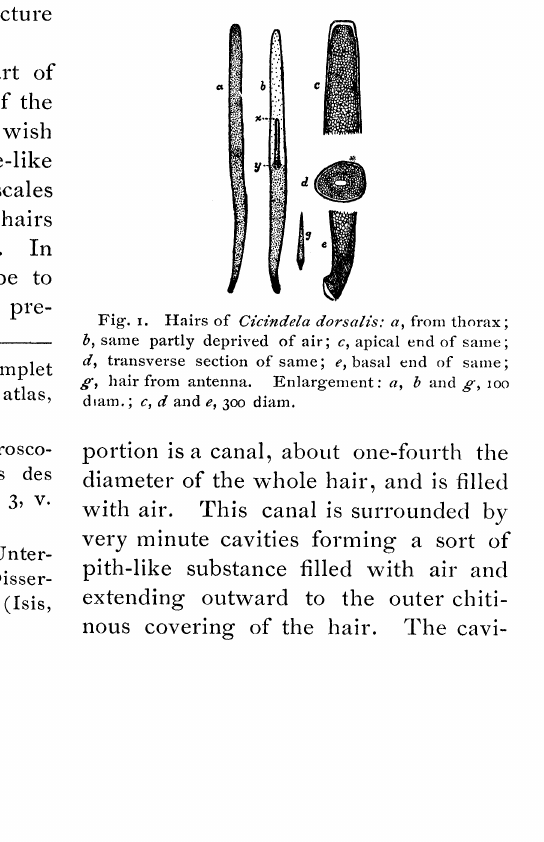
nous covering of the